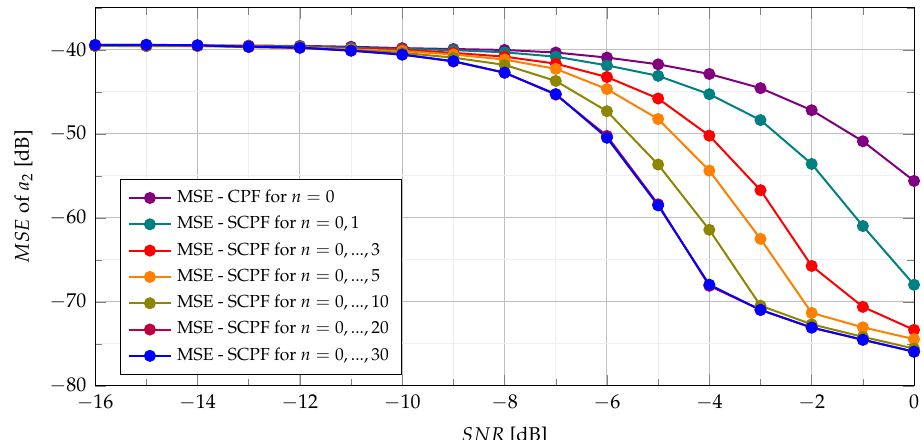
Figure 17. Influence of the number of SCPF slices on MSE for N = 63.